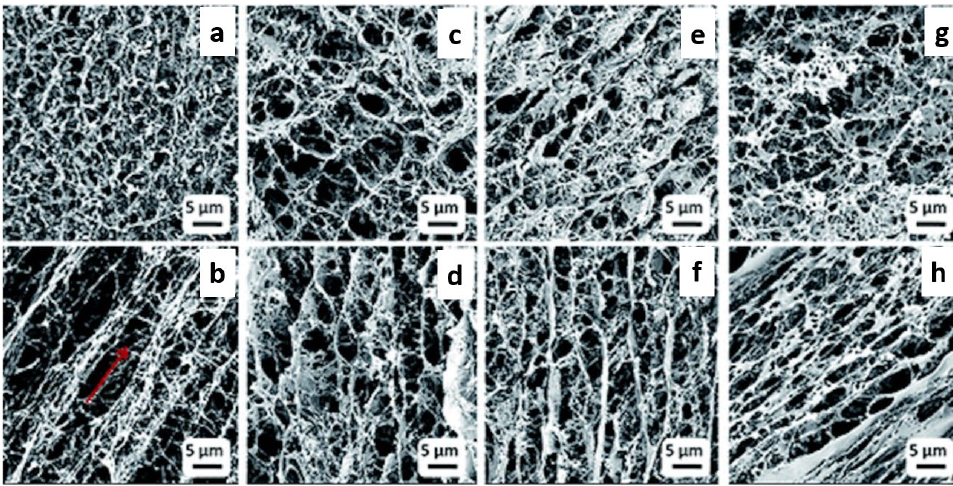
Figure 6. SEM images showing different morphologies of freeze-dried pure BC and BC/Chitosan (BC/Ch) composites obtained by varying the chitosan content. Pure BC ( a , b ); BC/Ch-1% ( c , d ); BC/Ch-1.5% ( e , f ); BC/Ch-2% ( g , h ). All images were taken at 5000× magnification with the top row showing the cross section and the bottom row is the inner wall of the composites (Adapted from Li et al. [141]).